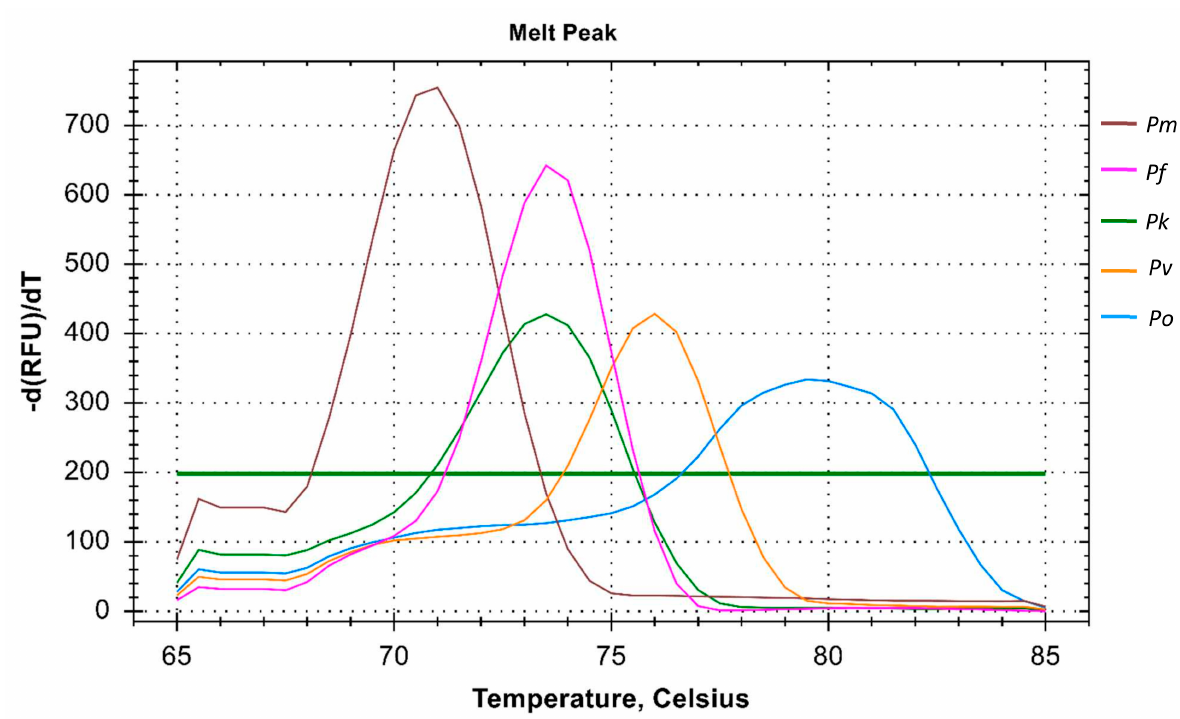
Figure 1. Melt curve analysis of Plasmodium spp. The melt curve shows different T m for Pf (73.5 ◦ C), Pv (76 ◦ C), Pm (71 ◦ C),